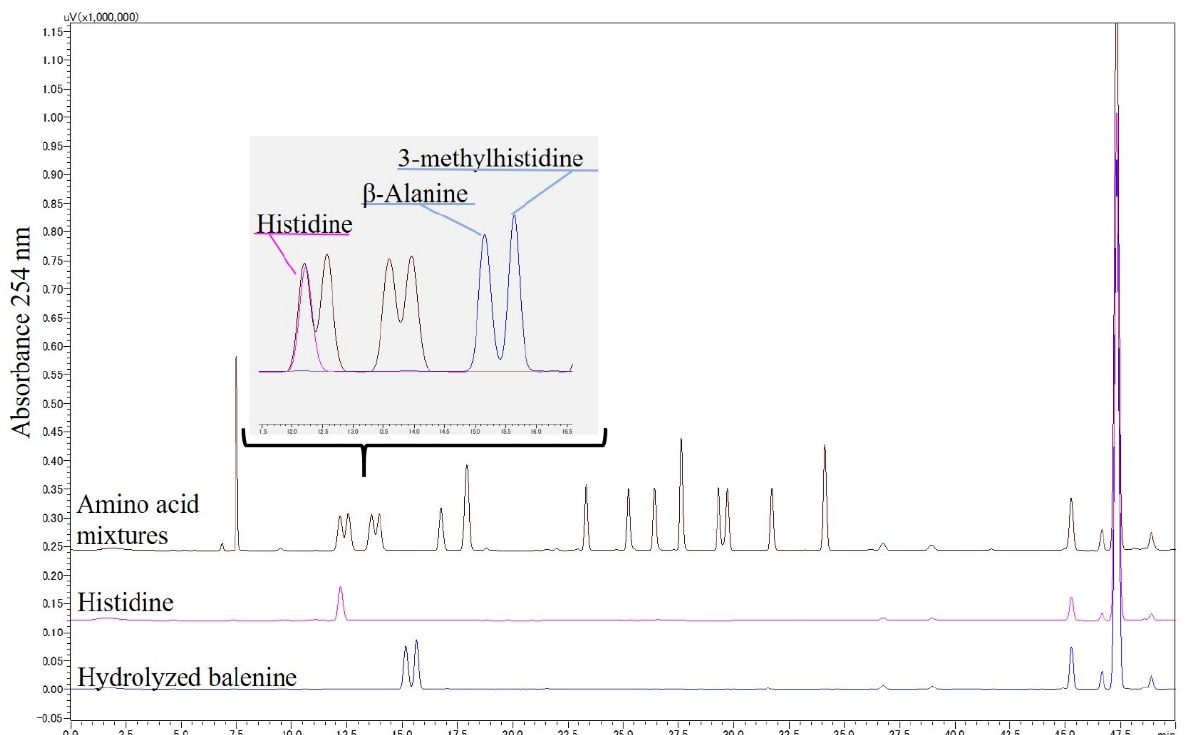
Figure 4 . HPLC chromatogram obtained after resolving PITC-derivatized histidine, β -alanine, 3- methylhistidine, and amino acid mixture. The resolution was conducted using an Inertsil ODS-3 column, and binary gradient elution was performed with 150 mM ammonium acetate containing 5% acetonitrile pH 6.0 and 60% acetonitrile at a flow rate of 0.5 mL/min.